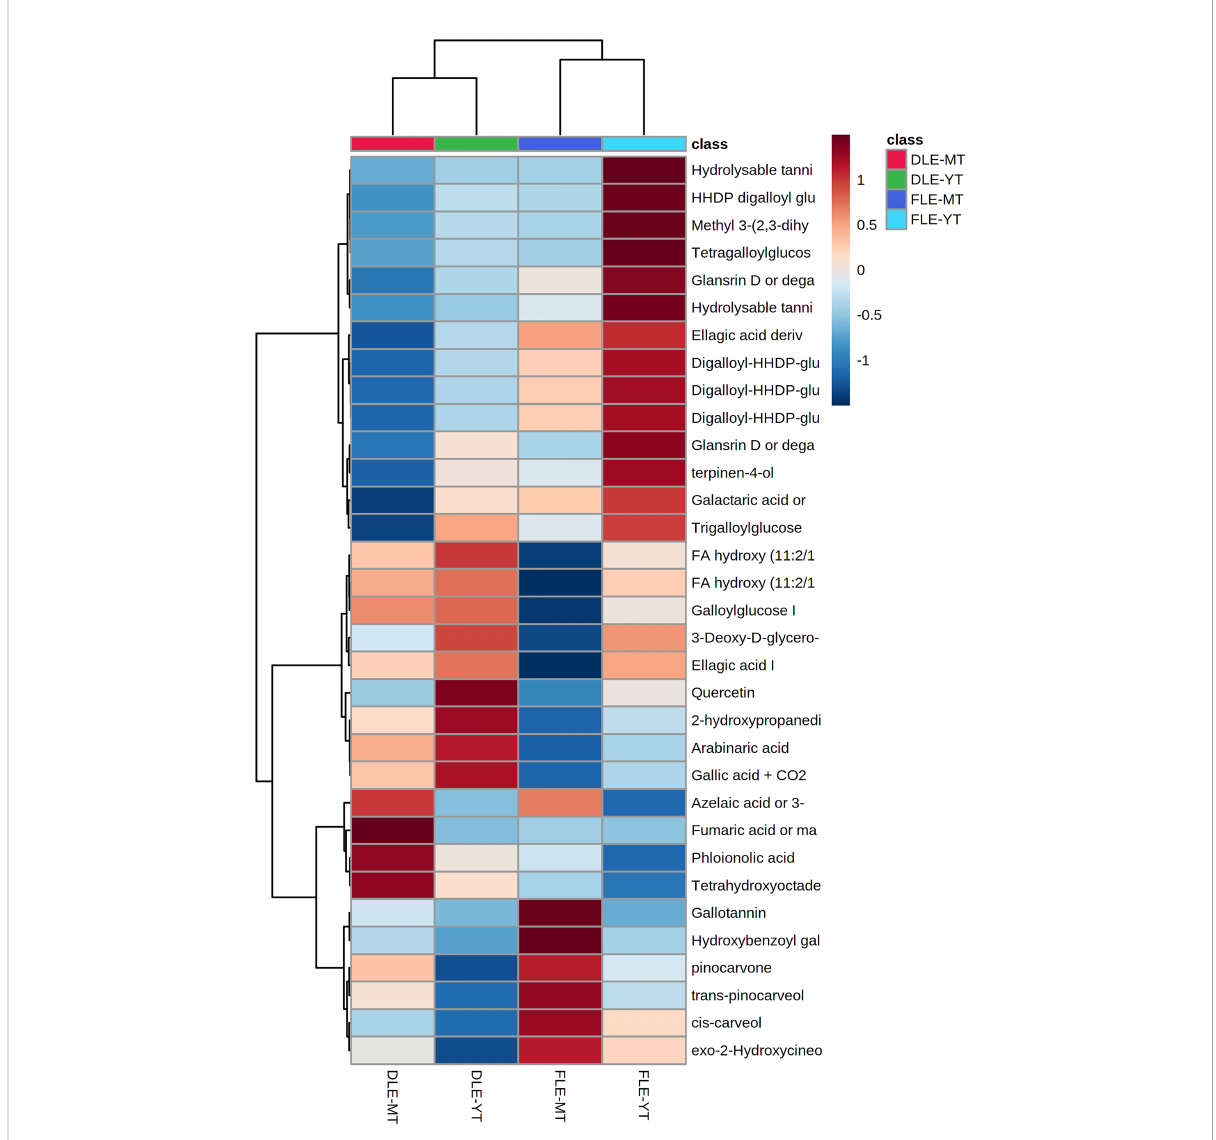
FIGURE 6 Heatmap showing the distribution of the 33 metabolites affected by both leaf pre-processing and the trees ’ maturity between the four groups of samples [aqueous extracts prepared with dried leaves of mature E. globulus trees (DLE-MT; red); aqueous extracts prepared with dried leaves of young E. globulus trees (DLE-YT; green); aqueous extracts prepared with fresh leaves of mature E. globulus trees (FLE-MT; purple), and aqueous extracts prepared with fresh leaves of young E. globulus trees (FLE-YT;